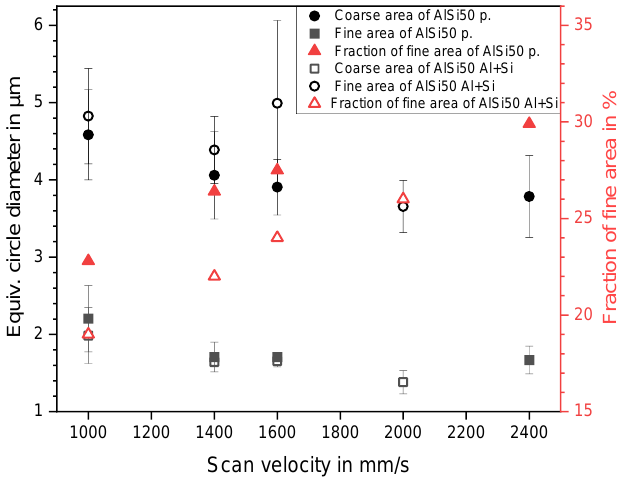
Figure 5. The equivalent circle diameter of the primary silicon and the fraction of the fine area in dependence on the scan velocity for AlSi50 p. and AlSi50 Al + Si samples.